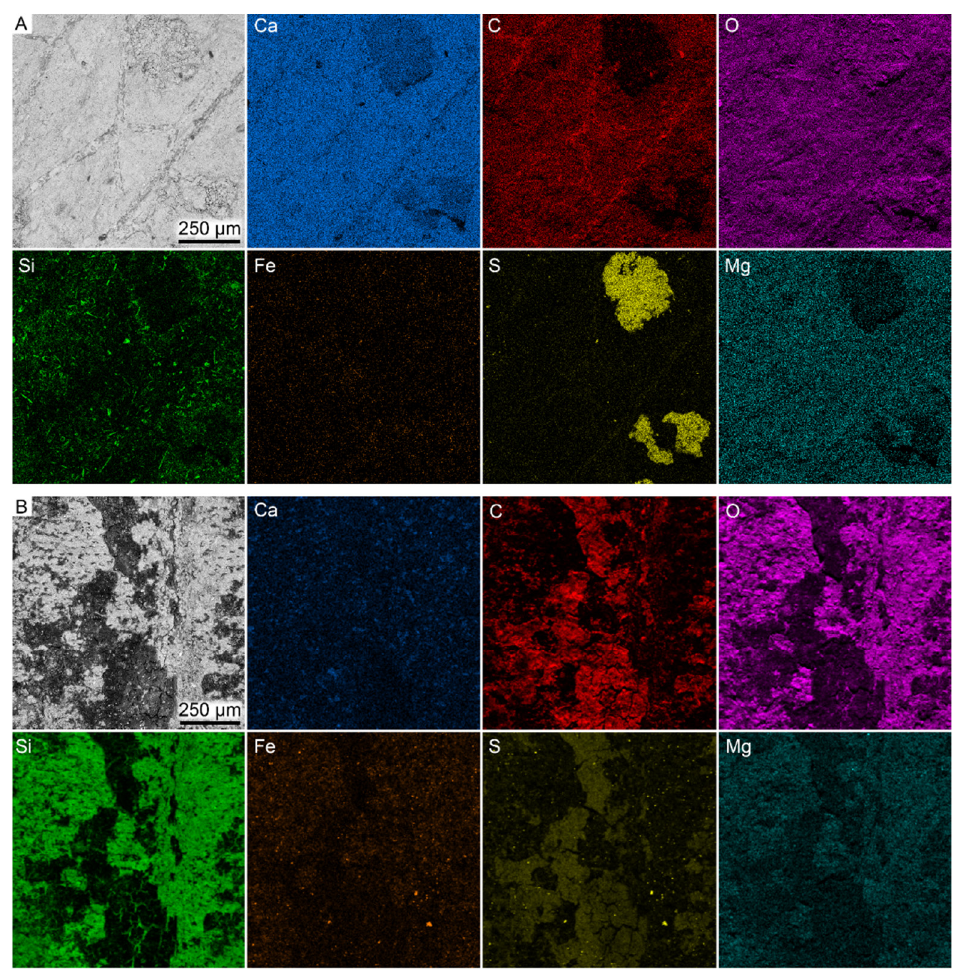
Figure 6. SEM-EDX elemental maps obtained from ( A ) wing veins in the wasp, FUM-N-11263, and ( B ) thorax of the damselfly, FUM-N-10904. C, carbon (red); Ca, calcium (blue); Fe, iron (orange); Mg, magnesium (cyan); O, oxygen (purple); S, sulfur (yellow); Si, silicon (green).